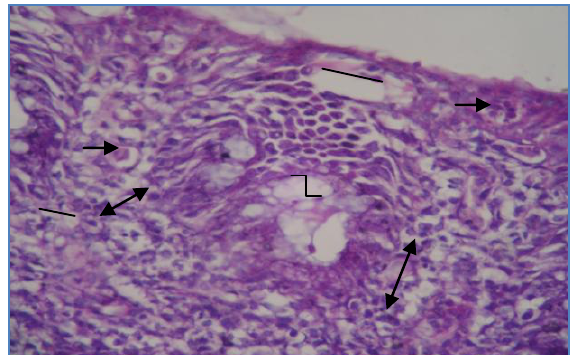
Figure, 2: Larynx shows focal vacuolation of epithelial and subepithelial layer ( ), epithelial cell infiltration ( ), goblet cell hypertropy of mucosal gland ( ) and intranuclear inclusion bodies ( ) 72 hrs. post infection (H and E), (400X).